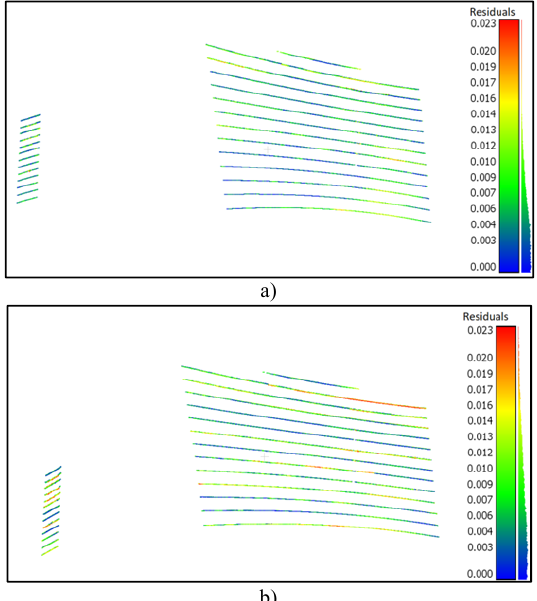
b) Figure 7. Residuals from corresponding planes after (a) and before (b) applying the intrinsic calibration